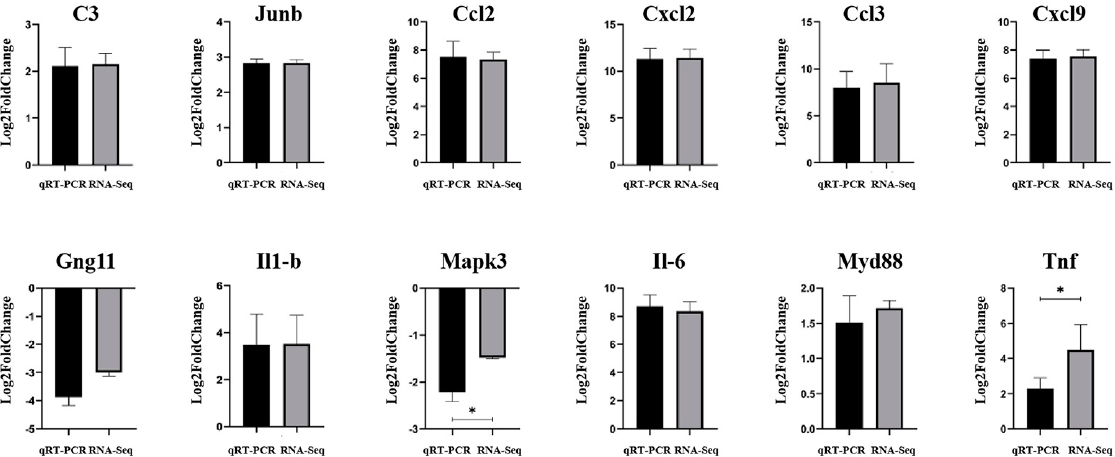
Figure 9. qRT-PCR results of the target gene. Black represents qRT-PCR verification results, gray represents RNA-seq results. Up-facing pillars indicate the gene expression was up-regulated, while the down-facing ones indicate the gene expression was down-regulated. * represents p <